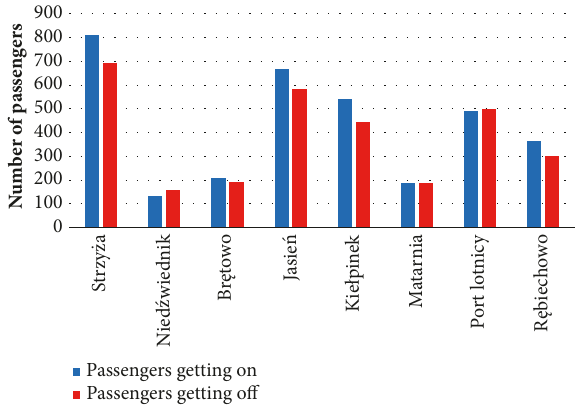
Figure 2: Average daily number of getting on and getting off passengers by the PMR line stations in the period of 17.10-16.11.2017. Source: own elaboration based on